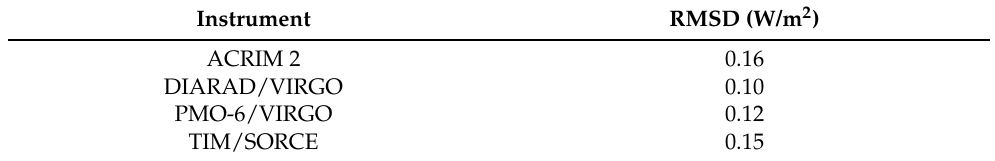
Table 3. RMSDs between longest individual TSI instrument time series and composite TSI time